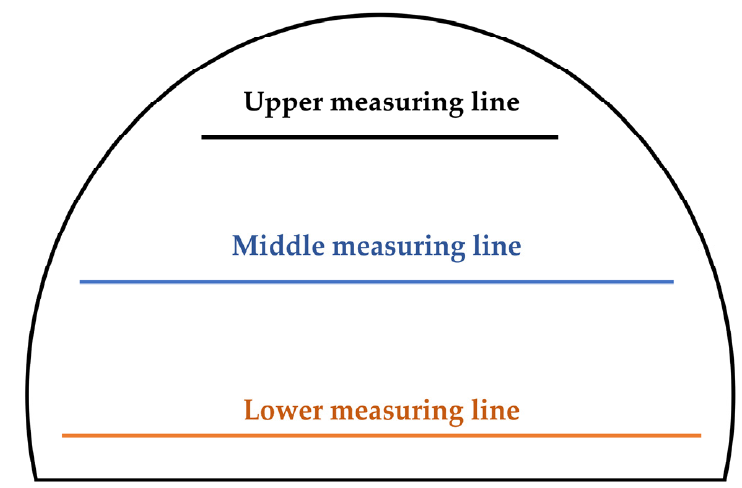
Figure 3. Layout of advanced geological prediction measuring line.